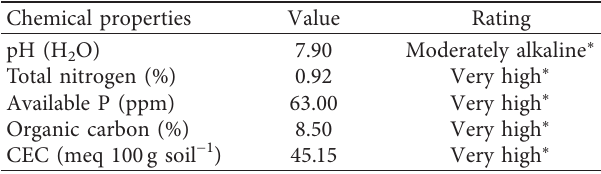
Table 2: Chemical composition of fresh cattle